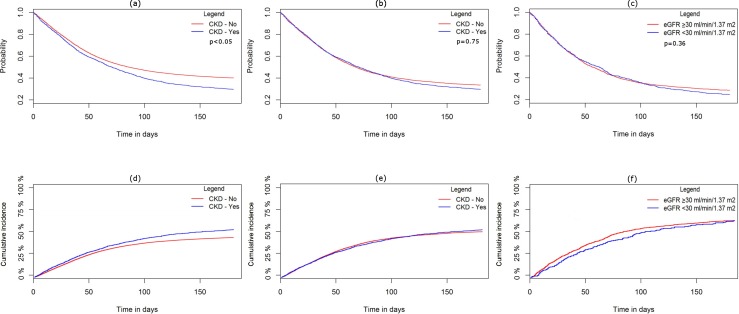
Survival curves.(a) Kaplan-Meier curve for all-cause mortality—main analysis–comparison among patients with and without chronic kidney disease. (b) Kaplan-Meier curve for all-cause mortality—first sensitivity analysis—comparison among patients with and without chronic kidney disease using a propensity-matched subpopulation. (c) Kaplan-Meier curve for all-cause mortality—second sensitivity analysis—comparison among patients with and without eGFR <30 ml/min/1.73m2 using a propensity-matched subpopulation. (d) Cumulative incidence for cardiovascular mortality—main analysis–comparison among patients with and without chronic kidney disease (Chi-square test statistic: 28.263; p-value < 0.001). (e) Cumulative incidence for cardiovascular mortality—first sensitivity analysis—comparison among patients with and without chronic kidney disease using a propensity-matched subpopulation. (f) Cumulative incidence for cardiovascular mortality—second sensitivity—analysis comparison among patients with and without eGFR <30 ml/min/1.73m2 using a propensity-matched subpopulation. Comparison among survival curves for all-causes was performed using log-rank test and the p-value was shown in the figure.